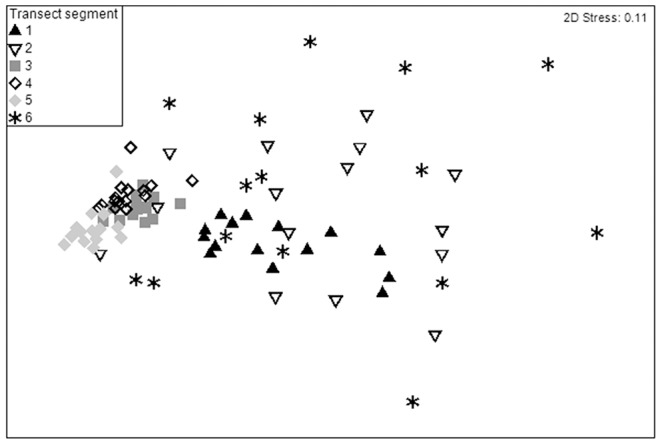
Non-metric multi-dimensional scaling (MDS) plot depicting megafaunal composition on each transect segment.Data have been fourth-root transformed. A 2-D stress value of 0.11 indicates a good fit of the data.